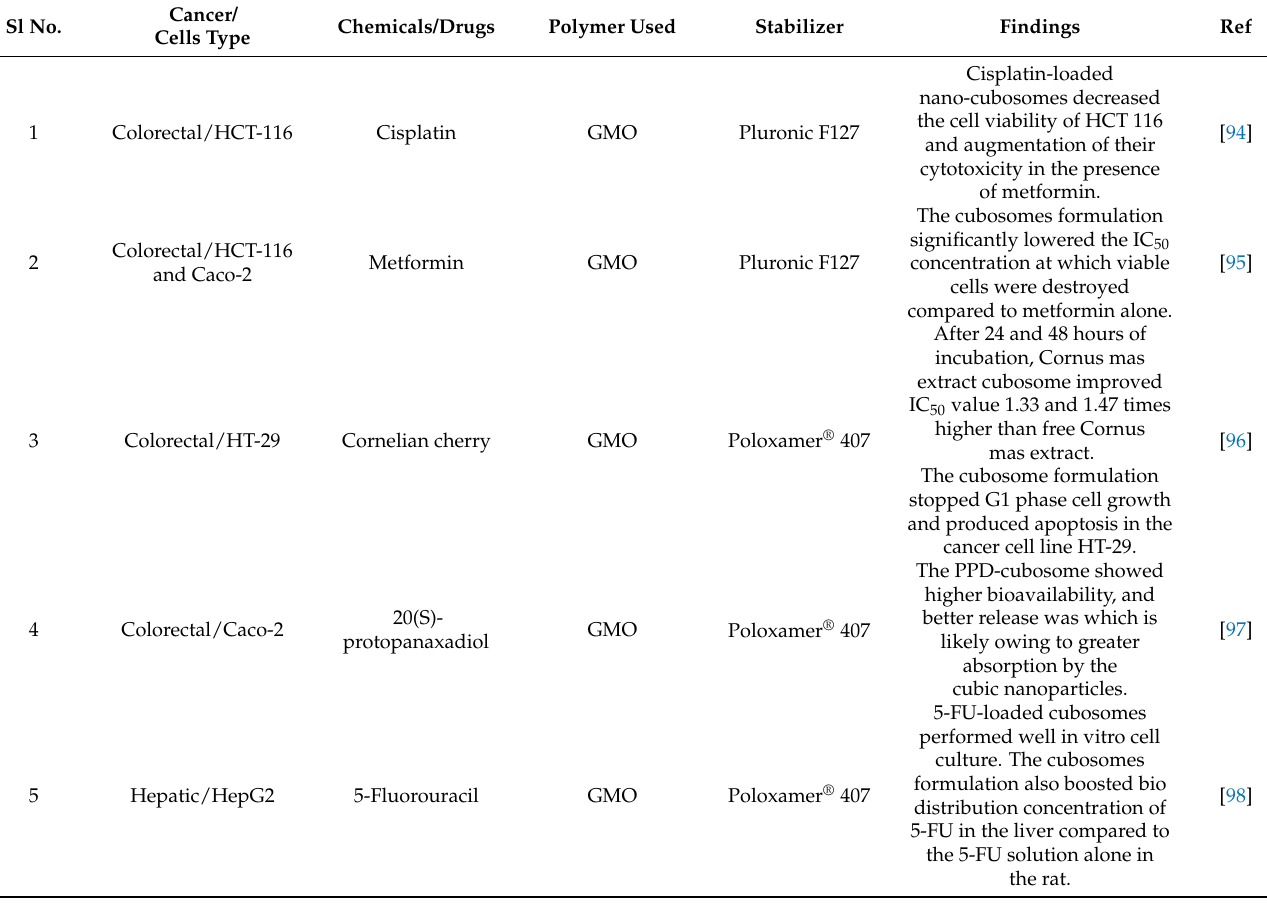
Table 1. Applications of cubosomes for anticancer drug